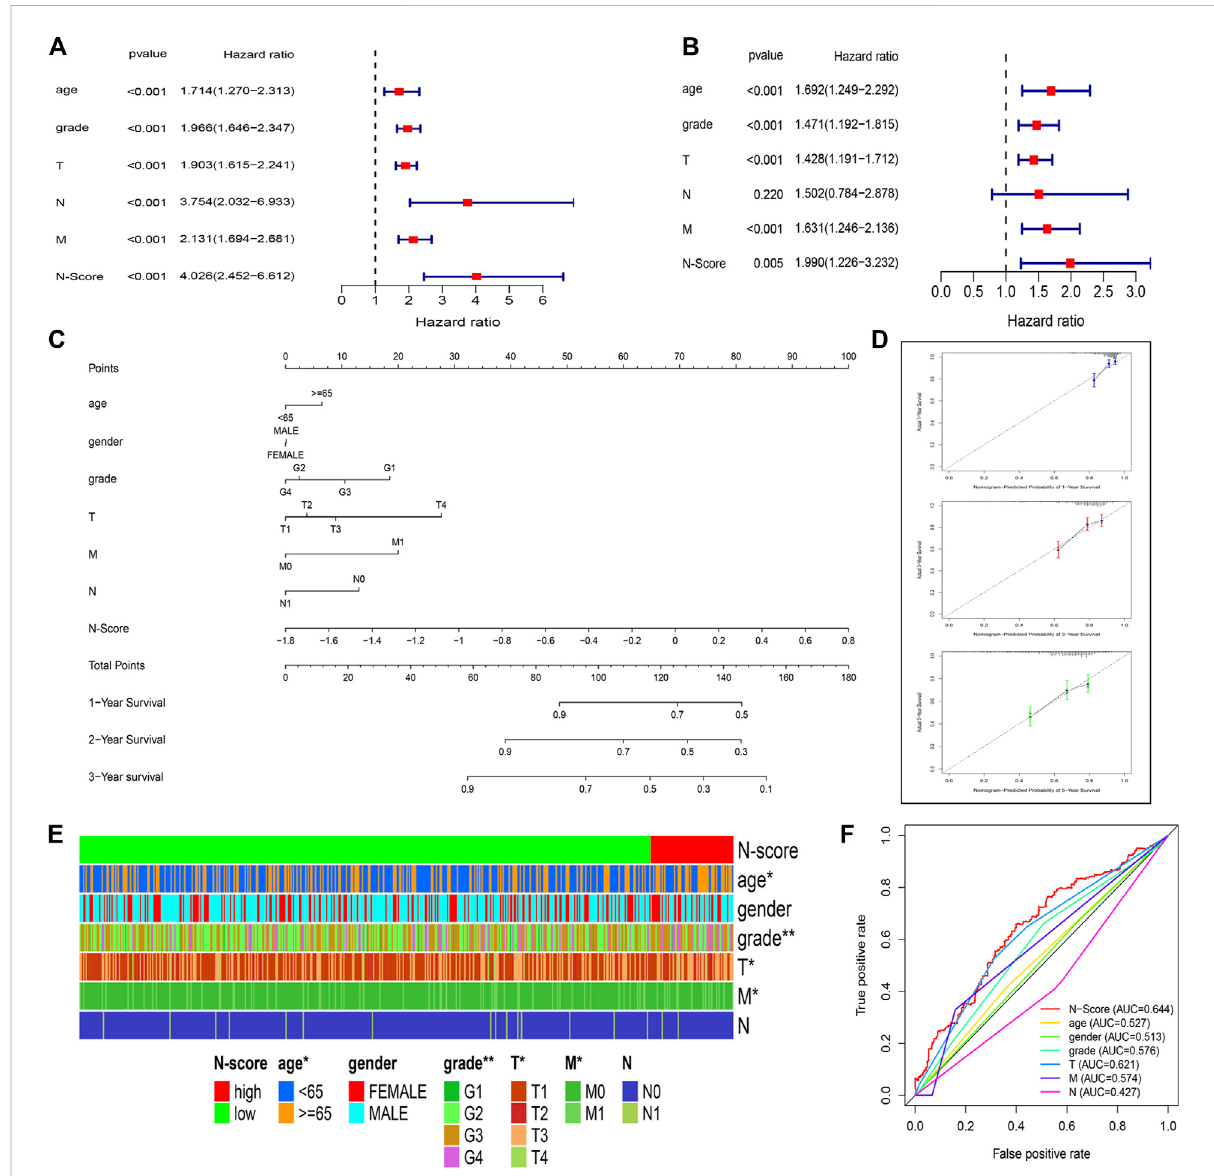
characteristics (age, gender, T stage, N stage, and M stage) and N-Score. (C) Nomogram combining the N-Score and clinical characteristics (age, gender, T stage, N stage, and M stage). (D) Calibrate curves of the nomogram in the 1st, 3rd, and 5th years. (E) Heat map shows the increase of N-Score is correlated with the increase of clinical characteristics (age, gender, T stage, N stage, and M stage). (F) Time independent receiver operating characteristic (ROC) curve for N-Score and clinical characteristics in the 3rd